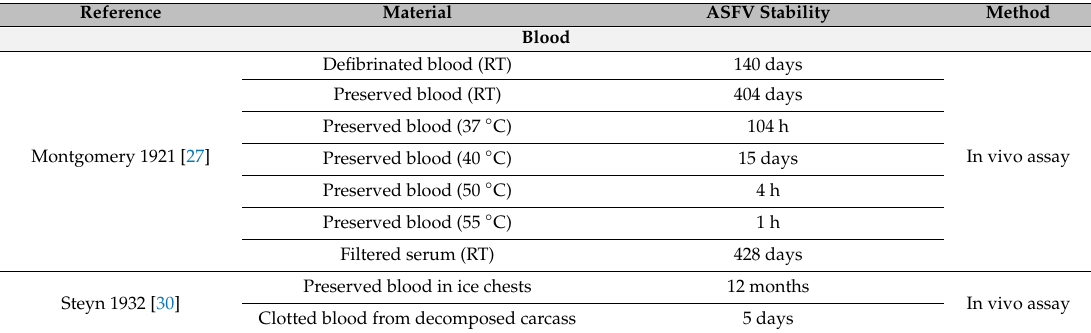
Table 1. Primary literature regarding the tenacity of African swine fever virus (ASFV) in blood, di ff erent organs and body